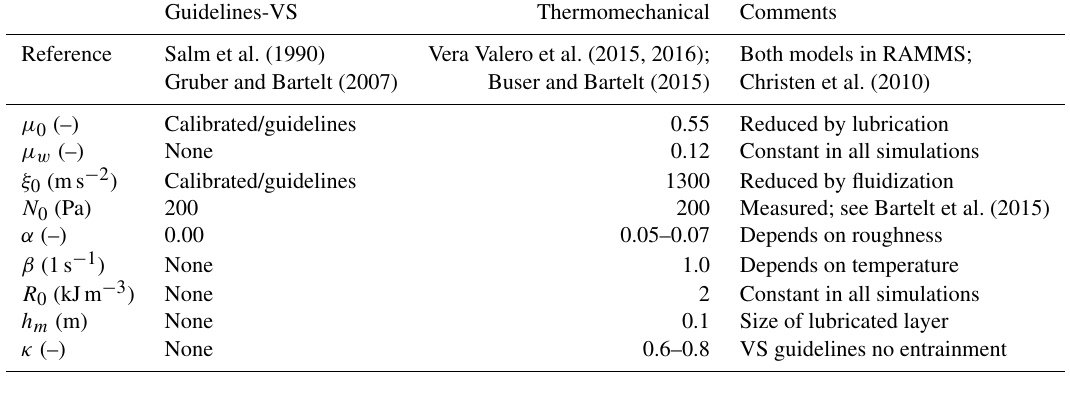
Table 4. Overview of model and model parameters used to simulate the 12 case studies.